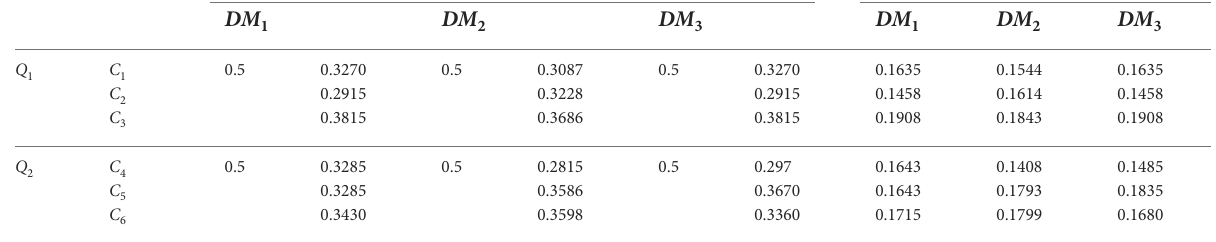
TABLE 9 Importantweightofthecriteria.